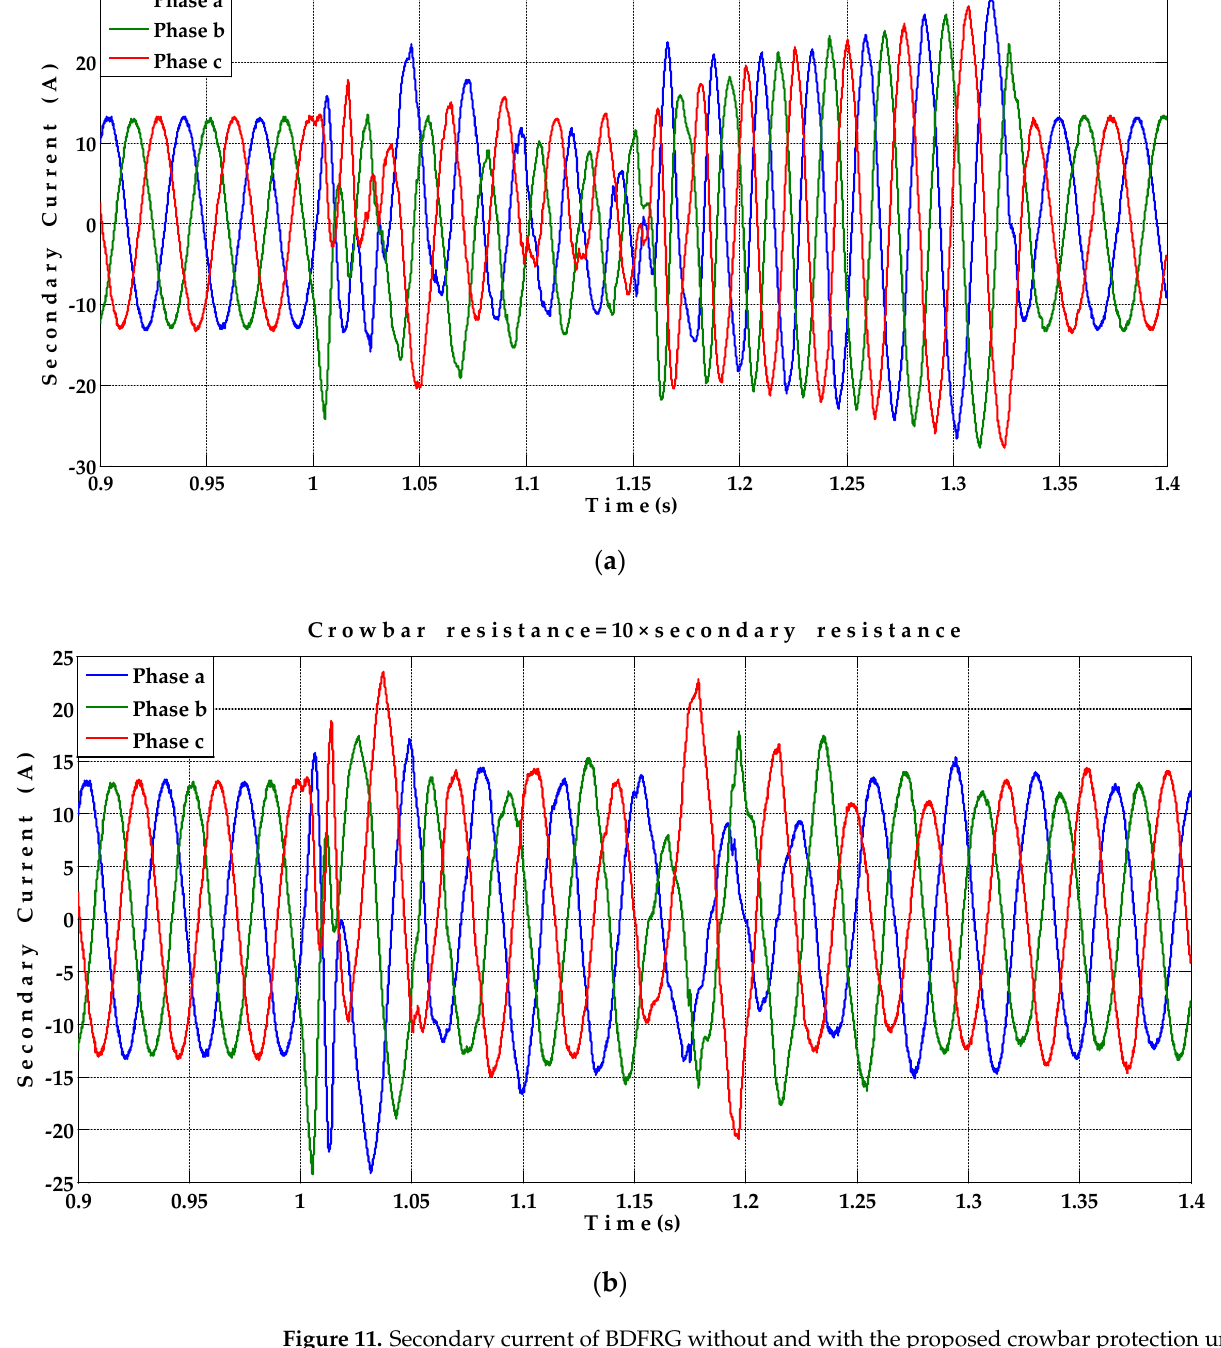
Figure 11. Secondary current of BDFRG without and with the proposed crowbar protection under symmetrical fault occurrence: ( a ) Without the proposed crowbar; ( b ) With the proposed crowbar. The dc link voltage of the BDFRG (with and without using the proposed crowbar) is shown in Figure 12, which has a reference value equals to 710 V. Under the fault occur- rence, in the case of “without using the proposed crowbar”, the dc link voltage was de- creased to about 499.2 V. In the case of using the proposed crowbar, the dc link voltage decreased instantaneously to about 587.8 V only, then the dc link voltage improved and returned quickly to its pre-fault value.